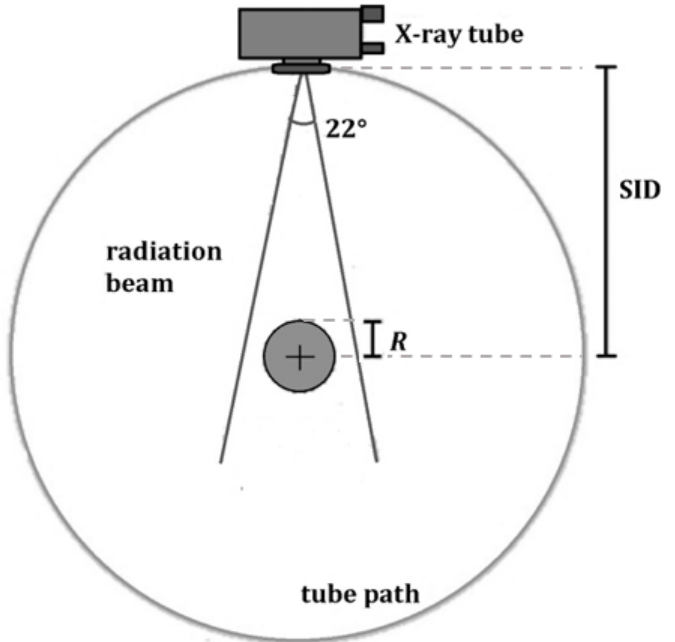
Figure 1. Diagram of the simulated geometry for the analytical model of the imparted dose at the surface (IDS). The theoretical phantom represents a water cylinder, the center of whose cross-section coincides with the microCT unit isocenter, and it was assumed that the radiation beam came from a point